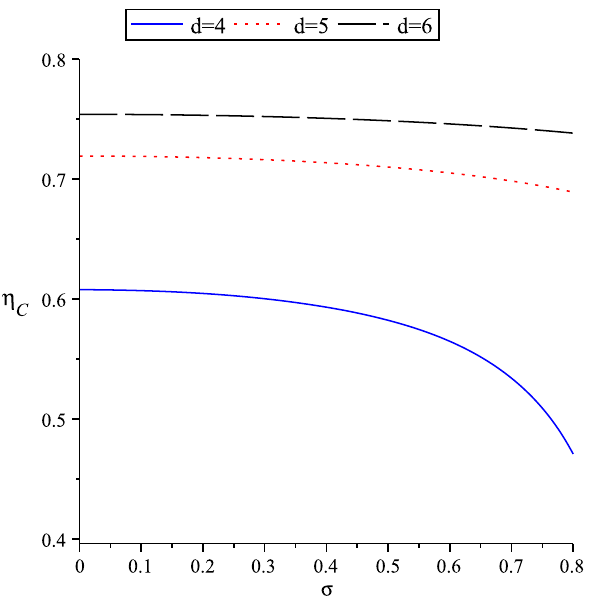
Fig. 6 Efficiency of the Carnot cycle as a function of the string cloud parameter σ